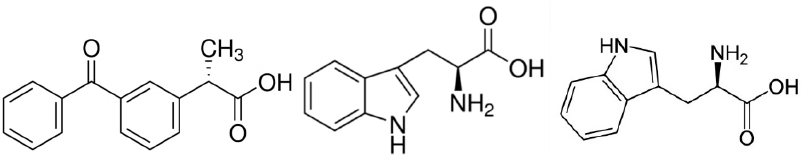
Figure 1. Chemical structures of S-Ketoprofen, L-Tryptophan, and D-Tryptophan optical